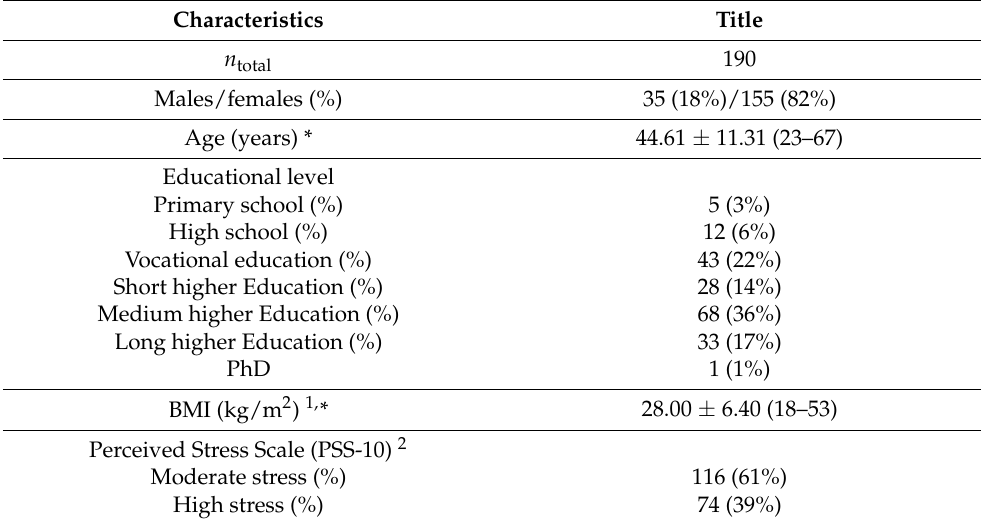
Table 1. Characteristics of